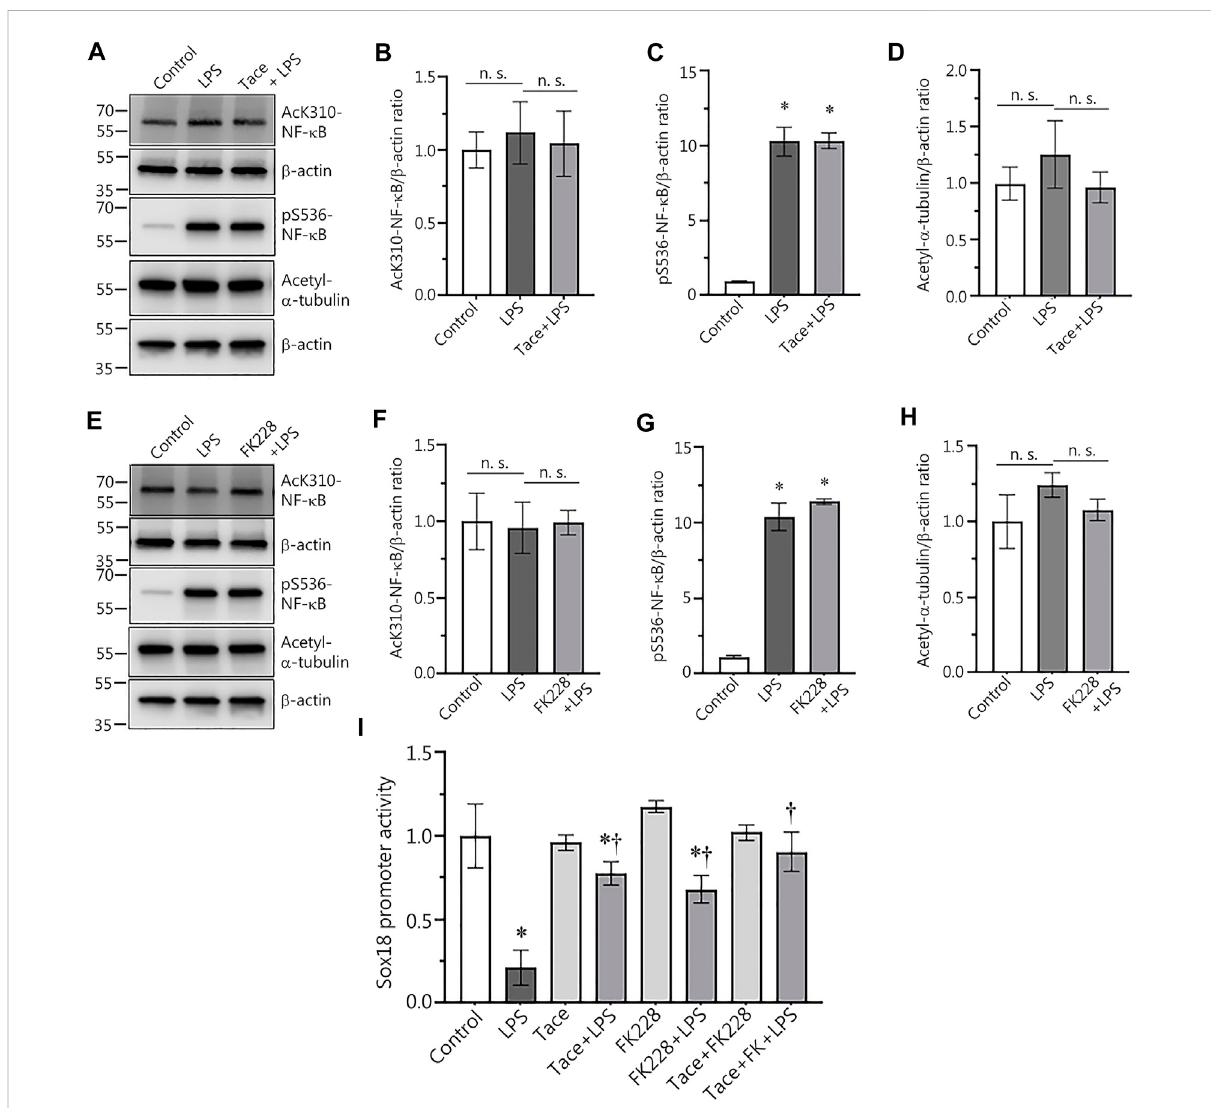
FIGURE 3 Pharmacological inhibition of HDAC1 and HDAC2 attenuates LPS-induced repression of Sox18 promoter activity in cultured human lung microvascular endothelial cells. Inhibitors of HDAC1 and HDAC2 did not affect NF- κ B acetylation (A,B,E,F) or NF- κ B phosphorylation (A,C,E,G) in HLMVEC. HDAC 1 or 2 inhibition did not alter the acetylation levels of the HDAC6 protein substrate, a -tubulin (A,D,E,H) . However, HDAC 1 or 2inhibitionattenuatedtheLPS-induced repression oftheSox18 promoter linked to aluciferase reporter (I) . Thecells werepre-treatedwith the inhibitorsorvehiclefor30 minthenchallengedwithLPSfor1 h (A – H) or5 h (I) .Dataaremean±SEM, n =3 – 6.* p < 0.05 vs .Control; † p < 0.05vs.LPS